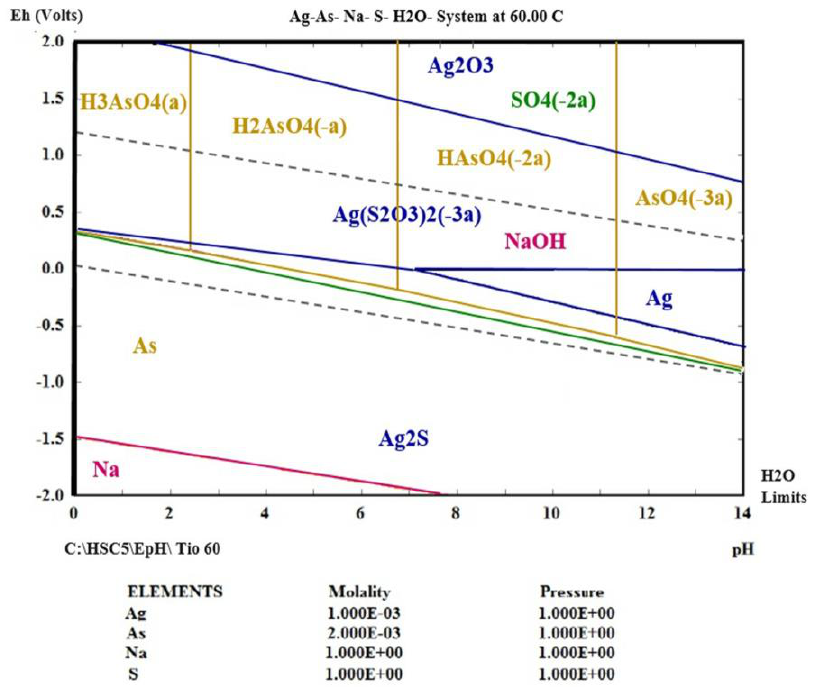
Figure 7. Diagram of the Eh-pH for the Ag–As–S–H 2 O system at 313 K.